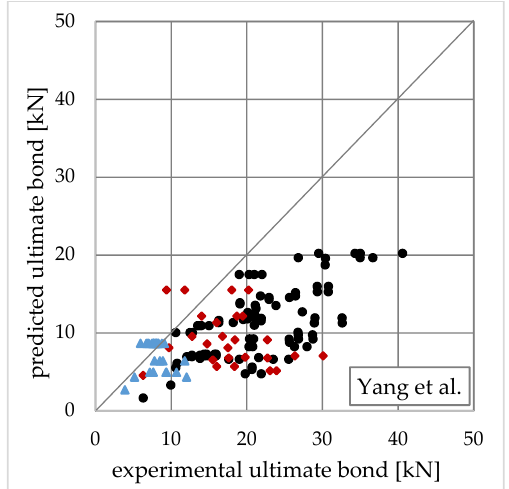
Figure 13. Test vs. predicted bond force using the Yang et al. model [25].